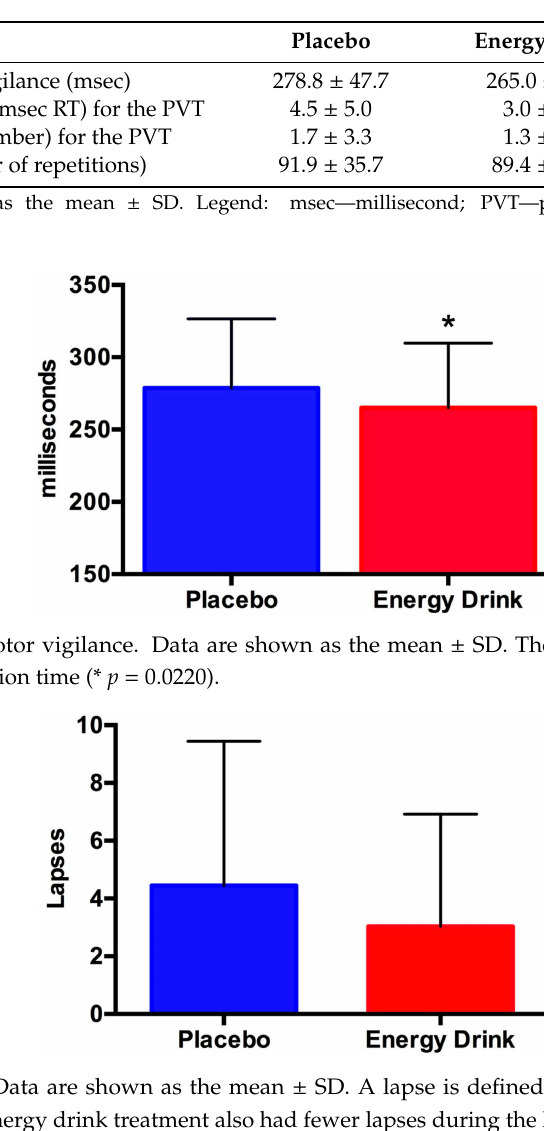
Table 1. Performance Data.